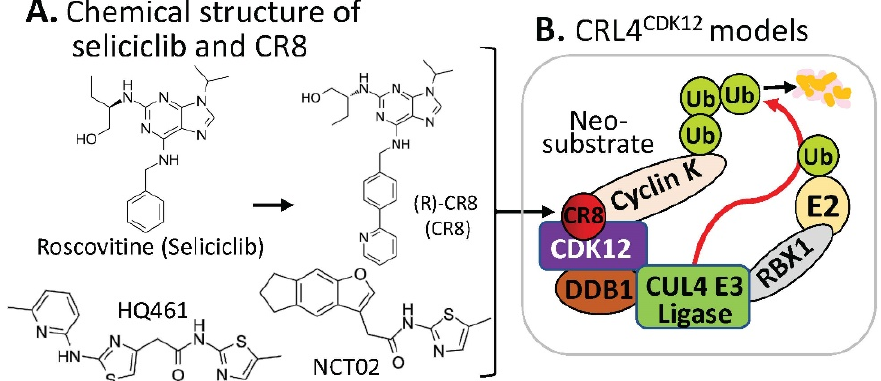
Figure 4. ( A ) The chemical structure of roscovitine/Seliciclib, CR8, HQ461, and NCT02 as MG com- pounds; ( B ) the substrate receptor-independent E3 ligase protein complex model for ubiquitination of the neosubstrate cyclin K. The MG compound CR8 shown in ( A ) was found through a substrate receptor-independent manner (neither CRBN nor DCAF15 being involved) to glue CDK12–cyclin K directly on DDB1–CUL4 E3 ligase complex to polyubiquitinate cyclin K. Then, the polyubiquitinated cyclin K would be degraded through the ubiquitination proteasome pathway. HQ461 and NCT02 may use a mechanism similar to CR8.